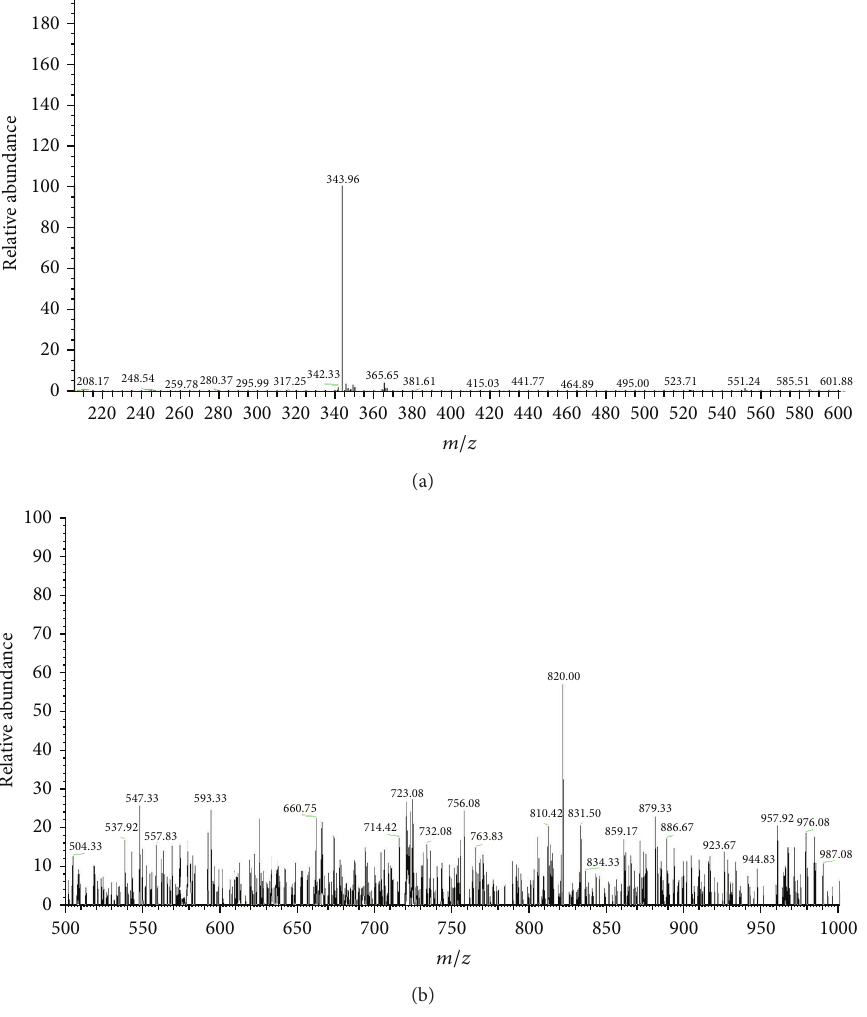
Figure 2: Mass spectrum of ligand (a) and copper complex (b). Table 3: Electronic spectral parameters and magnetic moment with suggested geometry of the